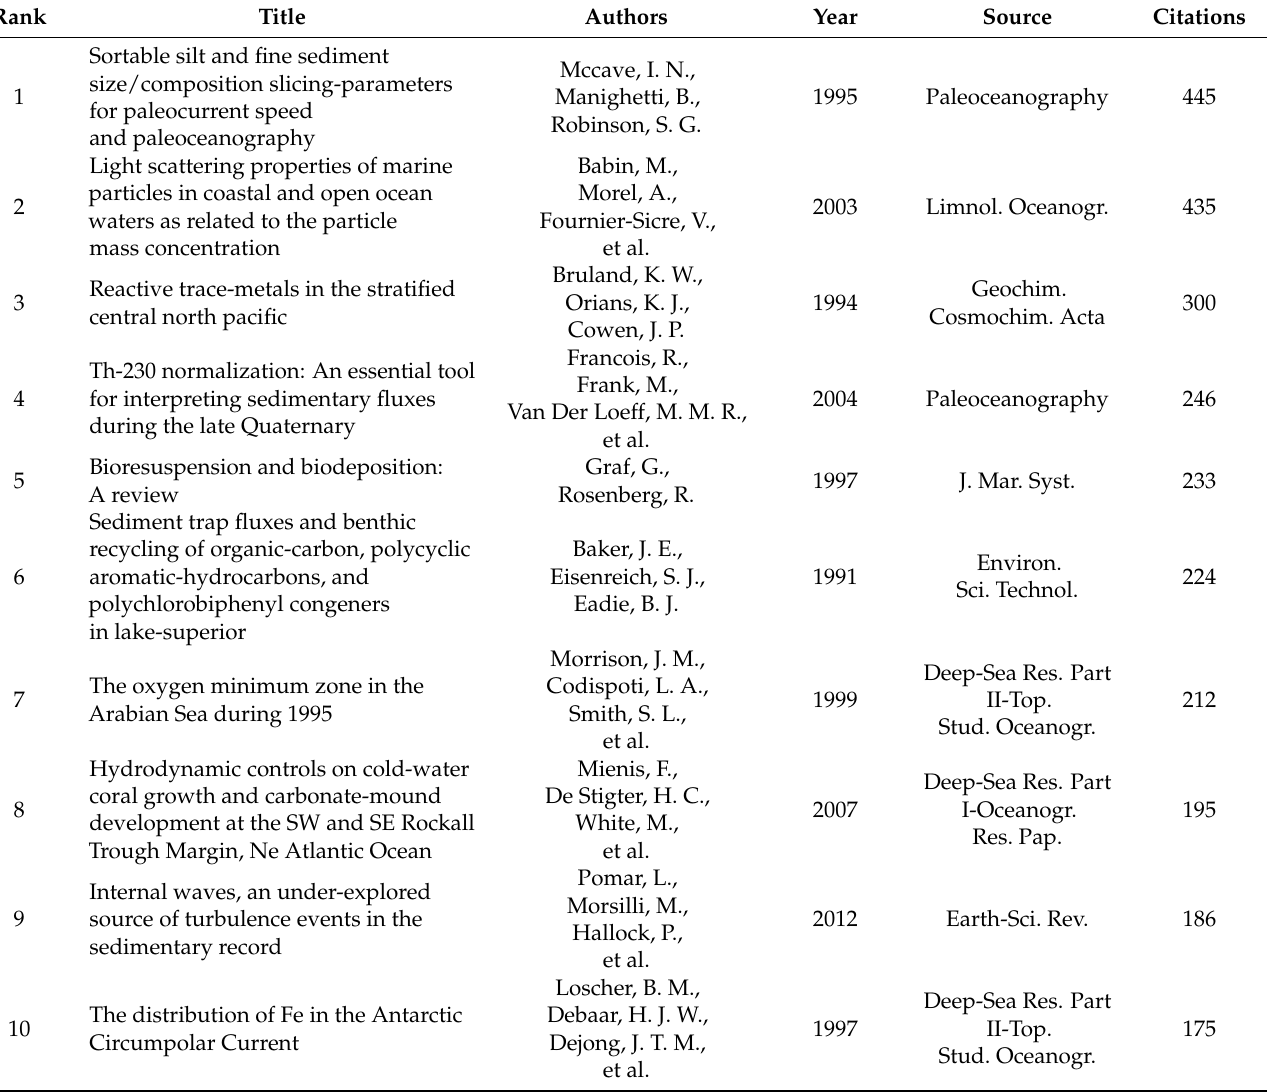
Table 4. Top 10 highly cited publications related to nepheloid layers from 1990 to